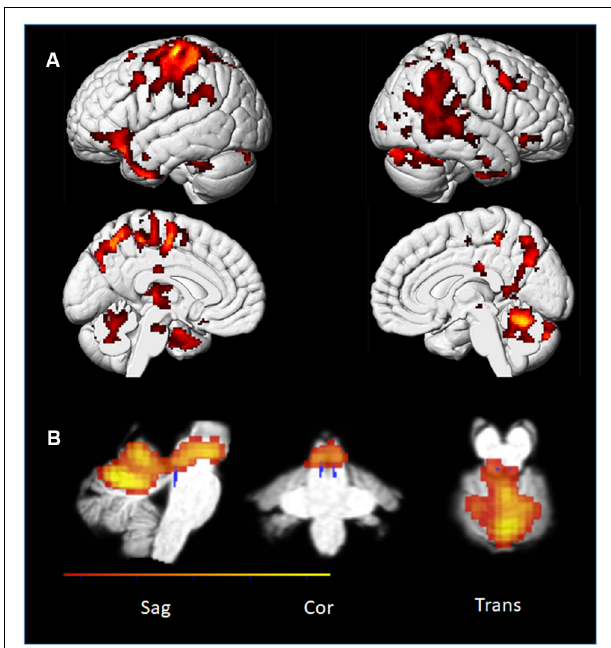
FIGURE 10 | PP’s brain: t -maps representing areas showing activation when playing the difficult music piece contrasted to the simple. Maps are corrected for multiple comparisons using FWE (Cortical: p < 0.05, k = 55; and p < 0.05, K = 8 for the brainstem using the SUIT mask). (A) t -map projected on an MNI template cortical mesh. (B) Parametric map from the subcortical specific analysis (on a cropped version of a normalized image of PP). The locus coeruleus (LC) mask from Keren et al. (2009) is shown in blue. Brain stem activations are displayed on the SUIT template (Diedrichsen, 2007) using MRIcron (Rorden et al.,